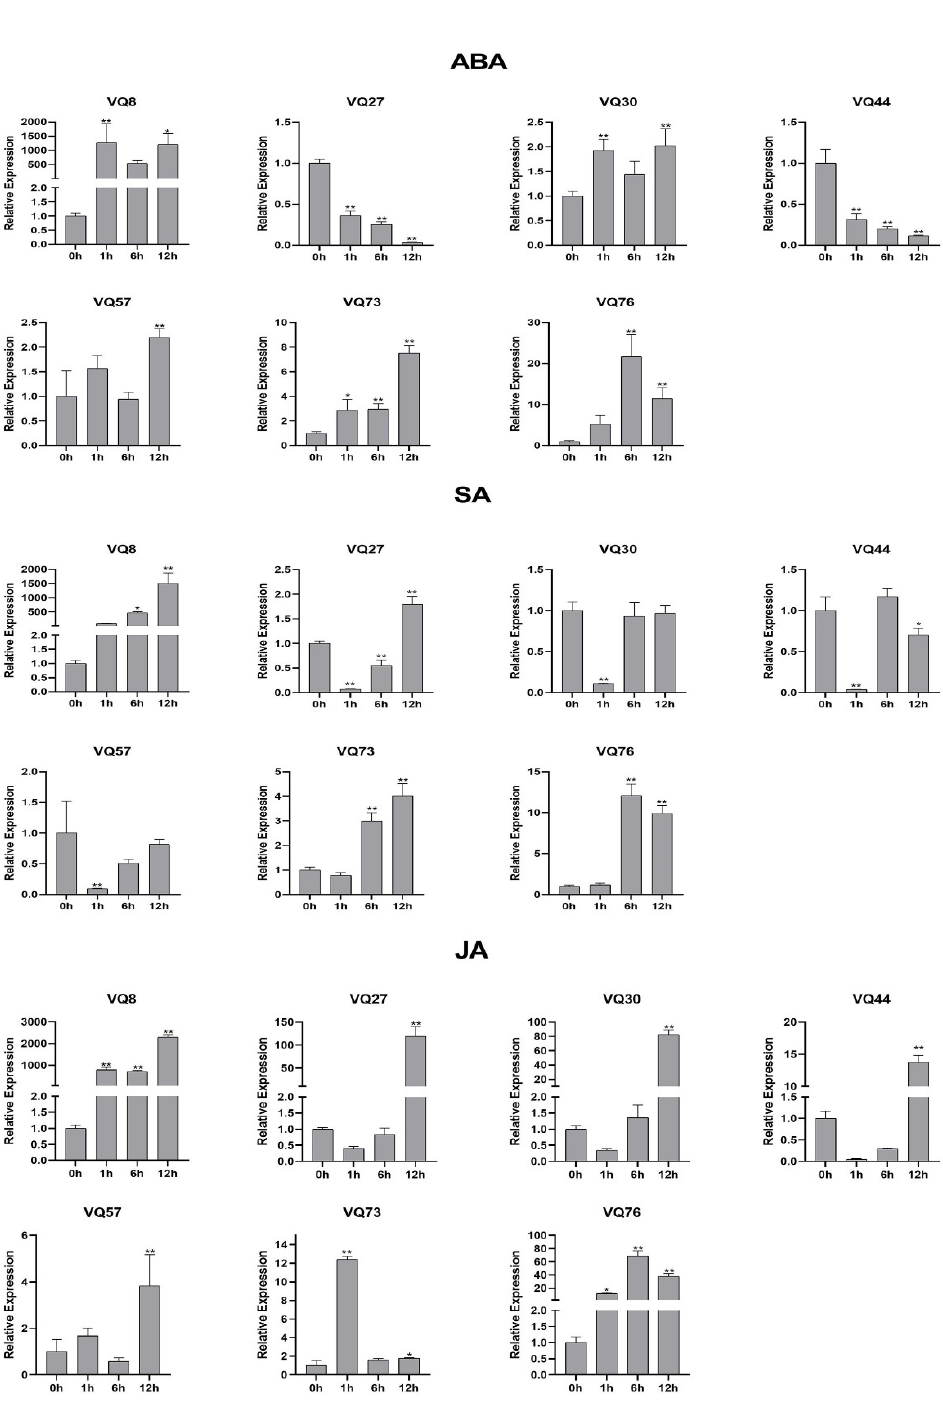
Figure 9. The expression profiles of eight selected VQ genes in response to different phytohormones. Plants were treated with ABA (100 μ mol/L), SA (5mmol/L) and MeJA (100 μ mol/L) for 0, 1, 6 and 12 h. The 25s-RNA gene was used as the internal control and to normalize expression data. Relative transcript abundance was normalized relative to the expression of CK at 0 h. The 2 −ΔΔ Ct method was used to calculate the expression of target genes at different times and treatments. Error bars represented the standard deviation of the mean. * means p < 0.05, ** means p < 0.01.